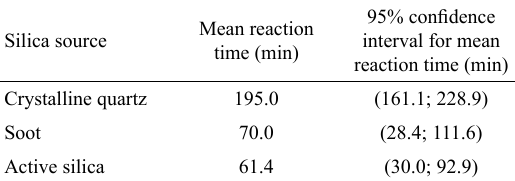
Table 5. Mean reaction times and 95% confidence intervals